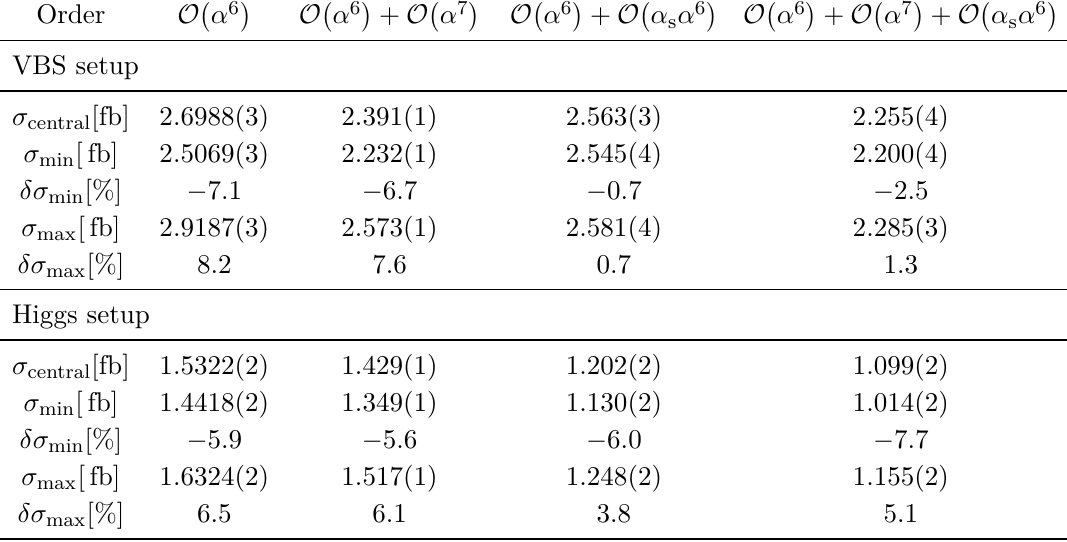
Table 3. Cross sections at LO and NLO with 7-point scale variation of µ fact and µ ren around the central value (3.1). We list the result for the central scale and those for the scales that show the largest deviation from the central value, both in absolute and relative quantities.